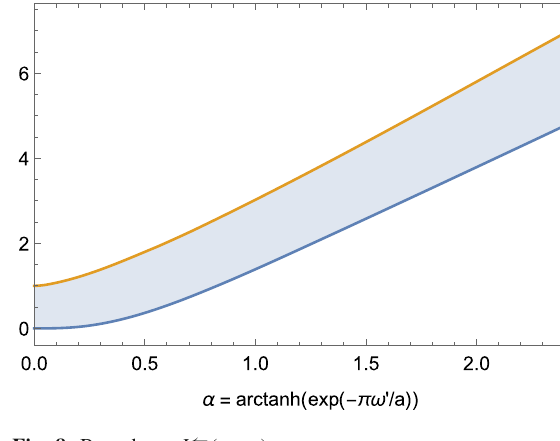
Fig. 8 Bounds on J ← (ρ I , II )